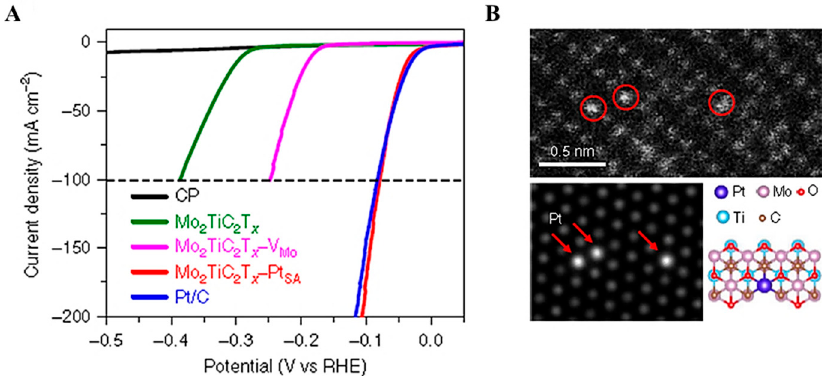
Figure 8. ( A ) Electrocatalytic performance for Mo 2 TiC 2 T x -PtSA and reference HeR catalysts. ( B ) Magnified HAADF–STEM image of Mo 2 TiC 2 T x -PtSA and its corresponding simulated image, as well as an illustration of the structure of Mo 2 TiC 2 T x -PtSA, showing the isolated Pt atoms (circles in c)